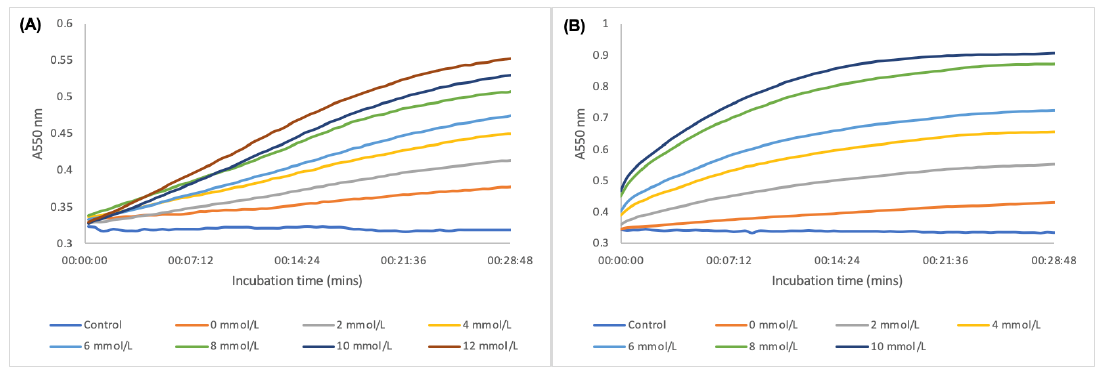
Figure 6. ( A ) Enzyme kinetic process in oxidising glucose and signal generation by deposition of Ag onto AuNSs during incubation at 37 ◦ C; ( B ) kinetic colorimetric detection of glucose after incubation at 37 ◦ C for 45 min and addition of detection